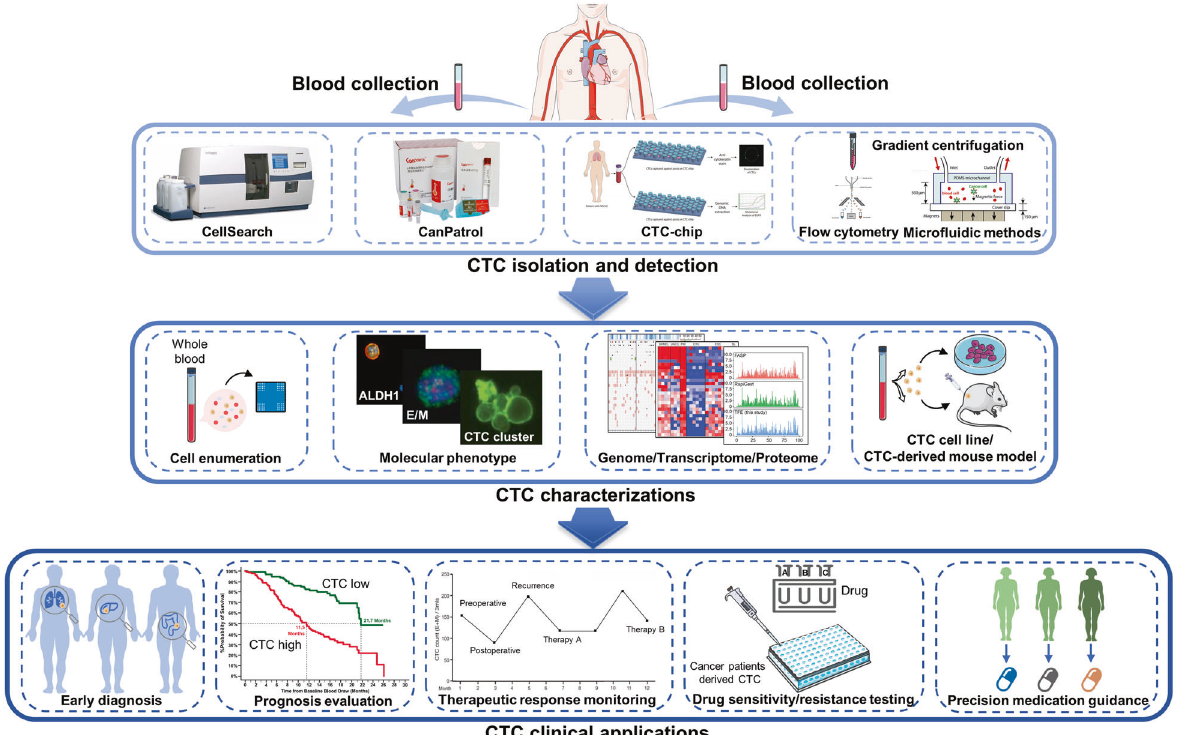
Fig. 4 Overview of the CTC isolation and detection, characterizations, and clinical